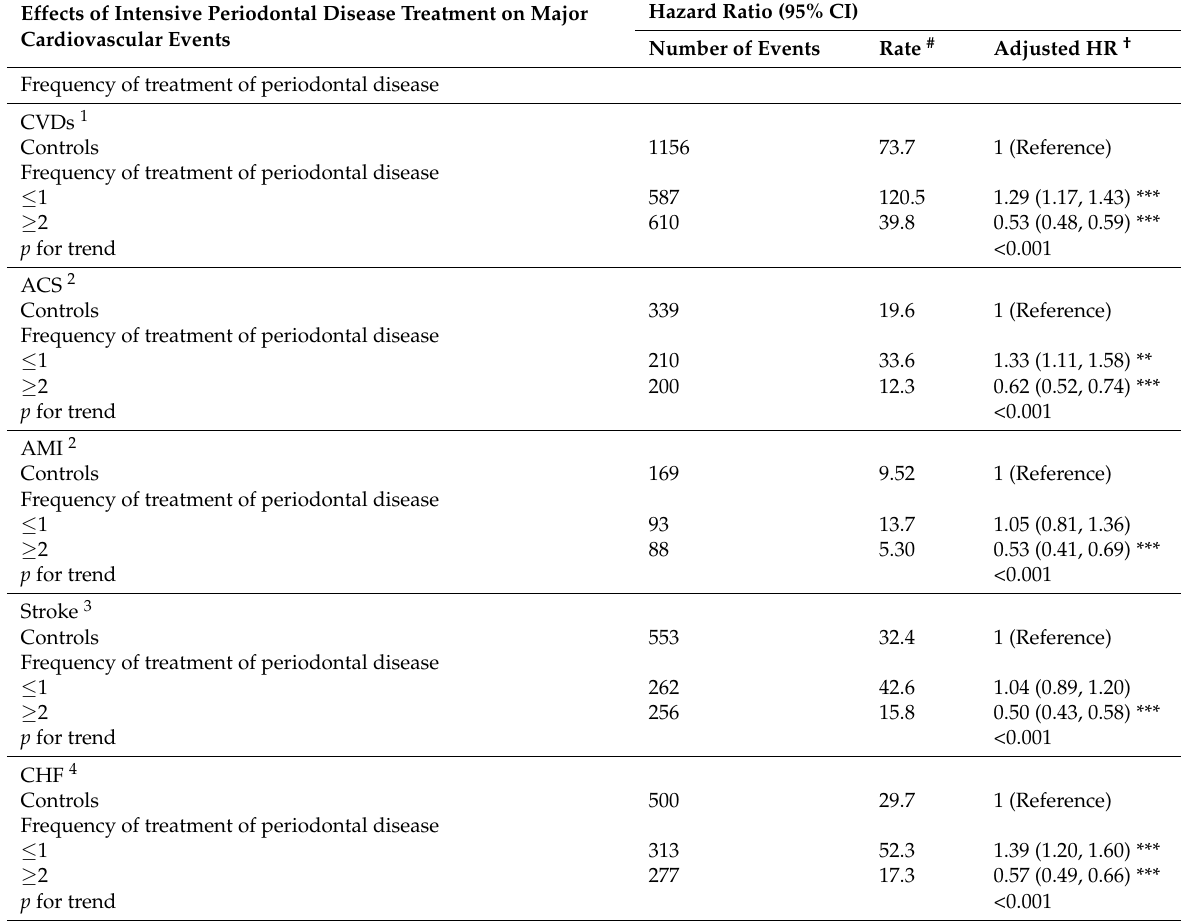
Table 5. Matched Cox proportional hazards model measured hazard ratio (HR) and 95% confidence interval (CIs) between outcome events and the frequency of clinic visit for intensive periodontal disease